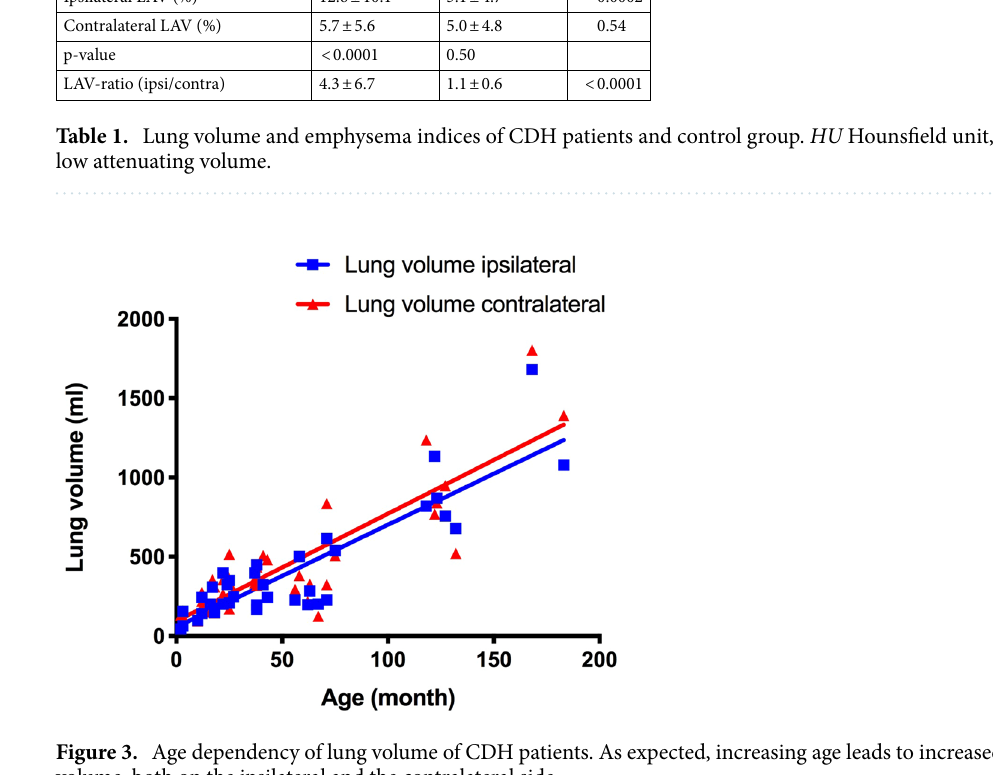
Figure 3. Age dependency of lung volume of CDH patients. As expected, increasing age leads to increased lung volume, both on the ipsilateral and the contralateral